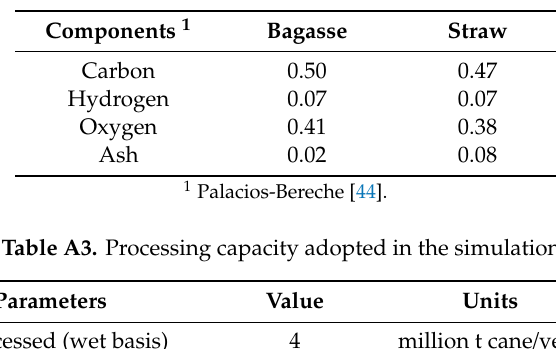
Table A2. Dry mass composition of sugarcane (SC) bagasse and straw.